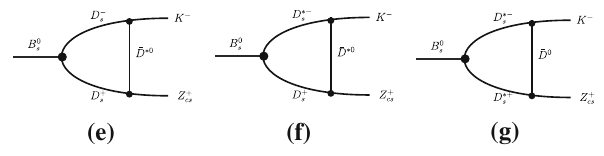
Fig. 2 Diagrams contributing to B + → φ Z + cs